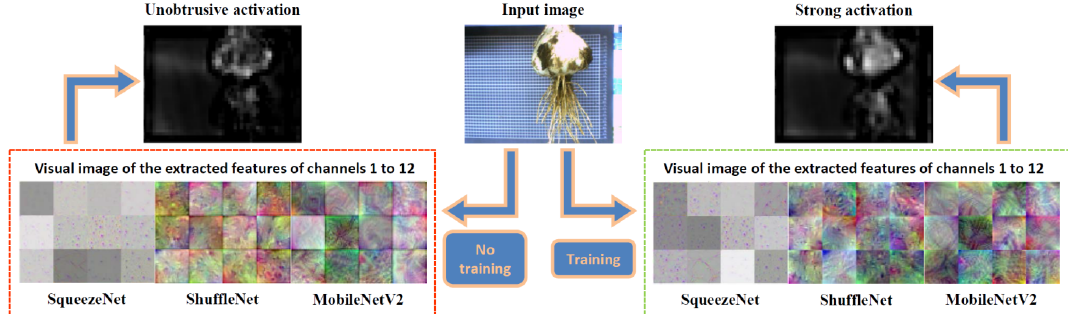
Figure 13. Comparison of model test results before and after training.